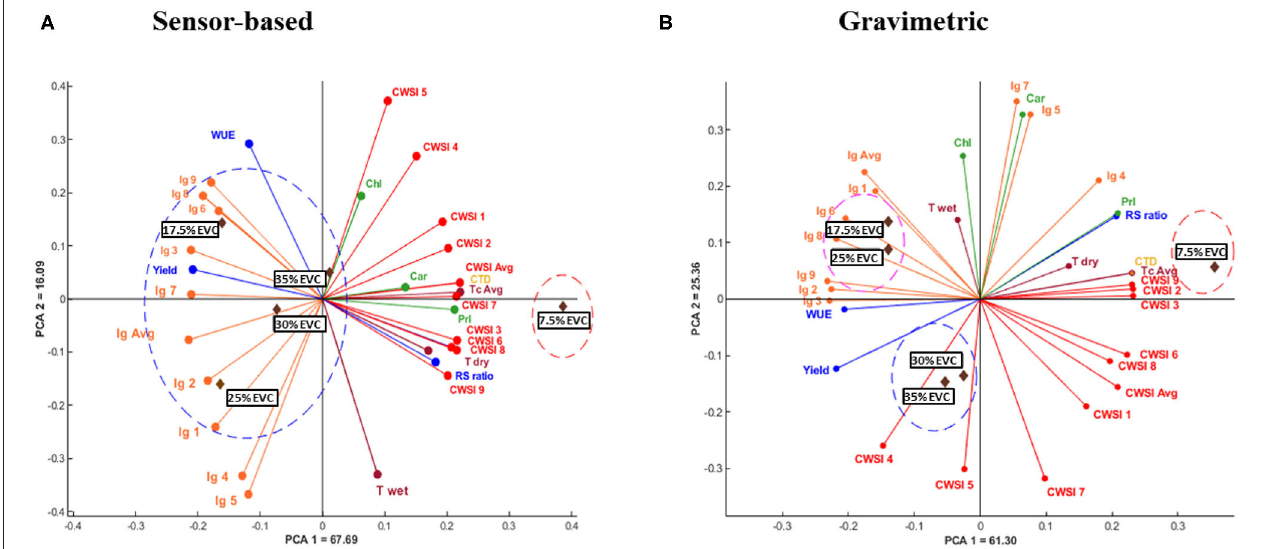
FIGURE 4 | (A,B) Multivariate data analysis showing principal components analysis (PCA) biplot for the studied parameters including water use efficiency (WUE), root: shoot (RS) ratio, yield, average canopy temperature (Tc Avg), maximum temperature (Tdry), minimum temperature (Twet), canopy temperature depression (CTD), average crop water stress index (CWSI Avg), proline (Prl), total chlorophylls (Chl), and carotenoids (Car) content derived from (A) - sensor-based and (B) - gravimetric irrigation methods. Numbered parameters including Ig 1–Ig 9 as well as CWSI 1 -CWSI 9 refer to the infrared index (Ig) and CWSI values obtained from corresponding